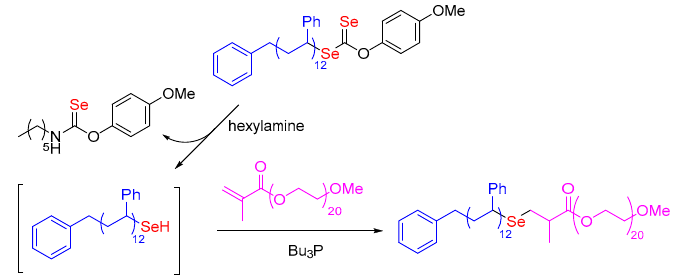
Scheme 2. Reaction route of aminolysis of diselenocarbonate organic compound with hexylamine and